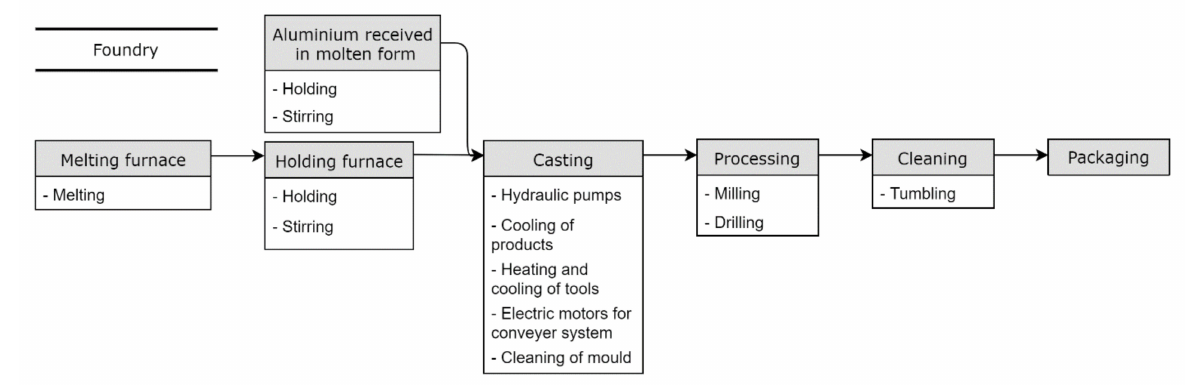
Figure 4. Production processes associated with aluminium foundries.